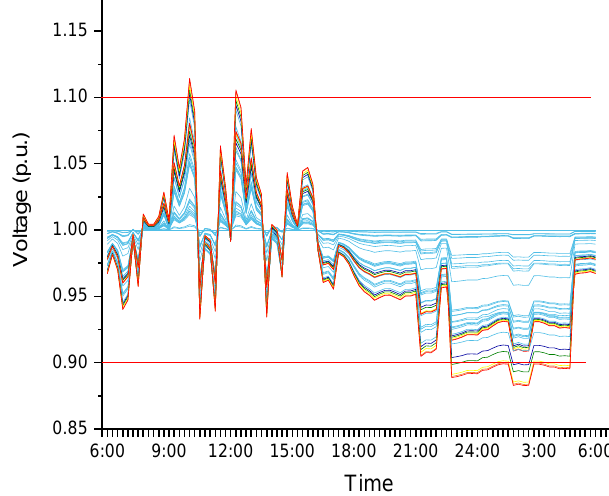
Figure 6. Voltage of 32-node of Case 2.